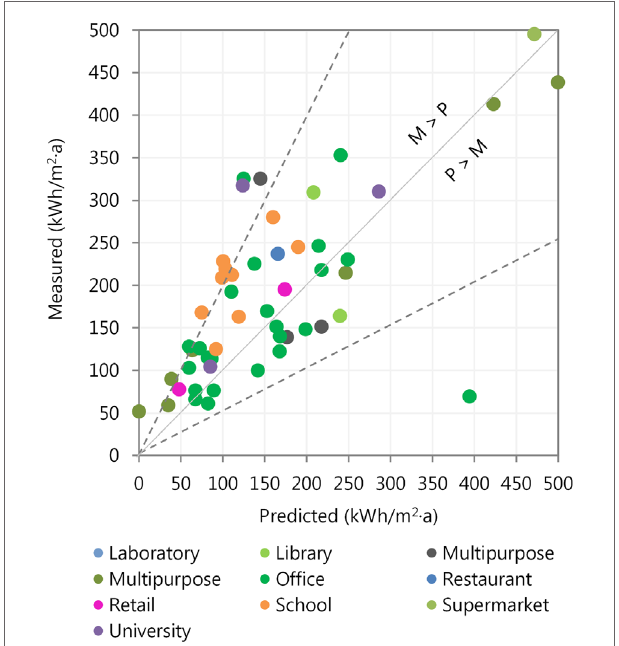
functions.FiGURe 2 | Predicted and measured energy use intensities of reviewed case studies for different building